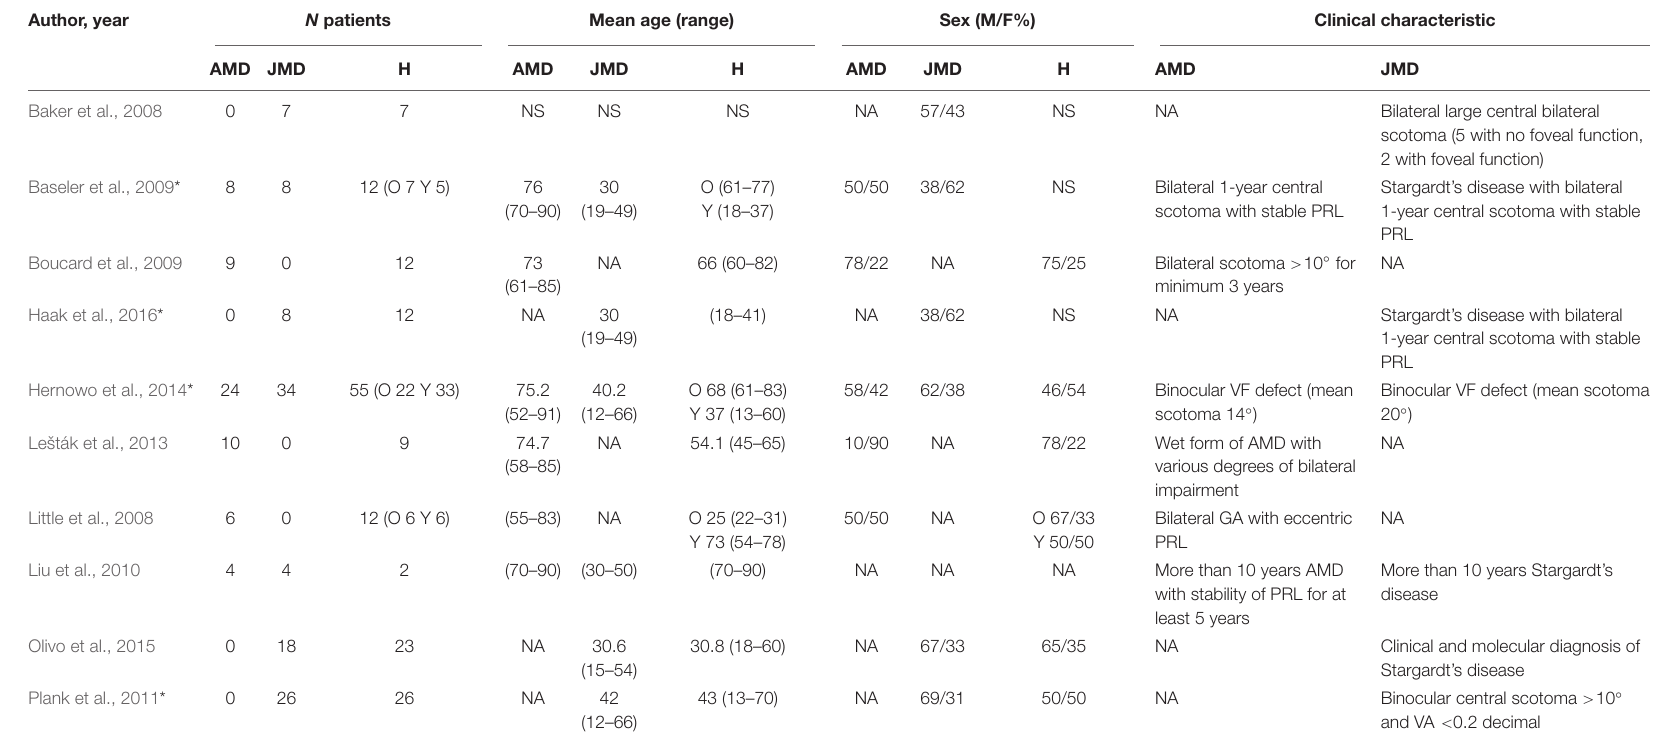
TABLE 1 | Demographic and clinical